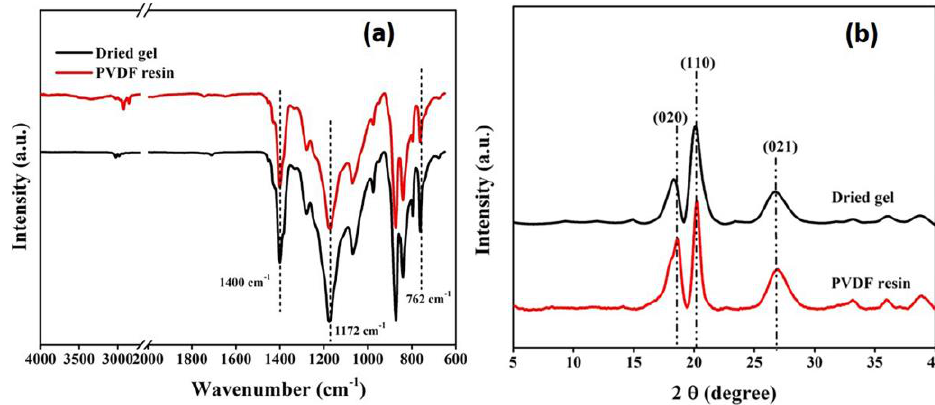
Figure 4. ( a ) FTIR spectra and ( b ) XRD pattern of dried gel and PVDF resin.